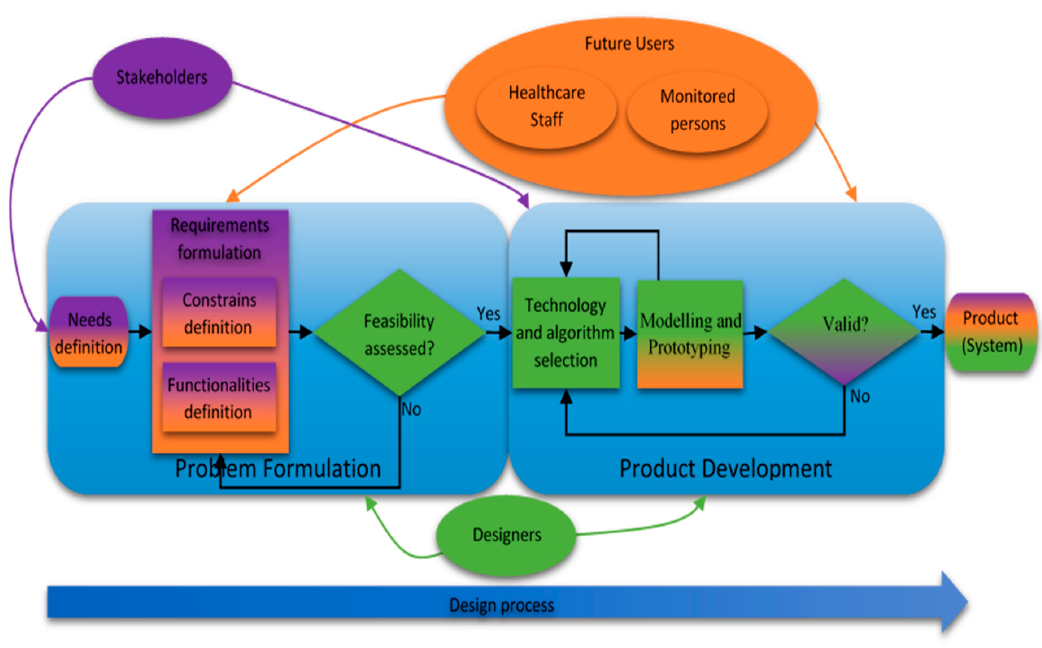
Figure 1. Flowchart of the proposed design methodology.